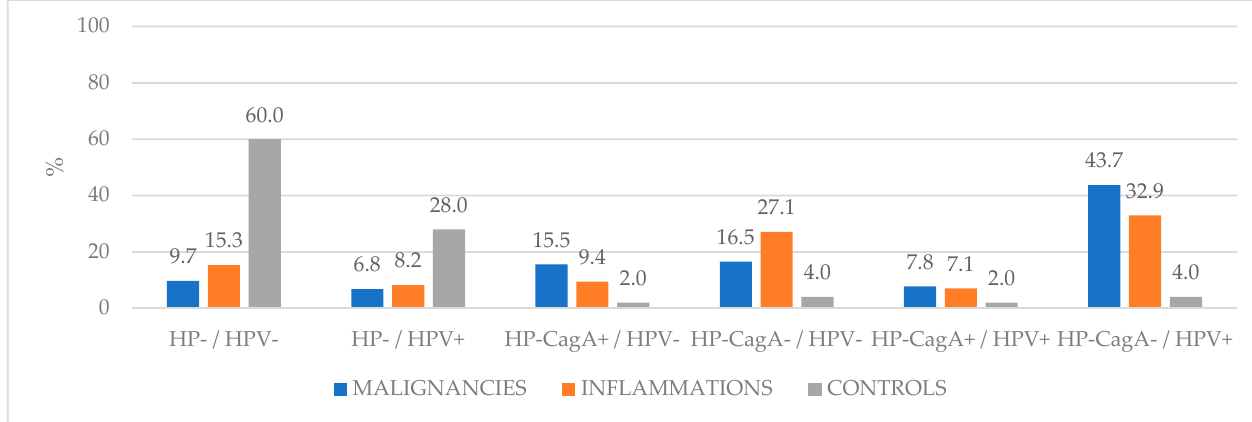
Figure 1. Samples with different co-infection combinations.